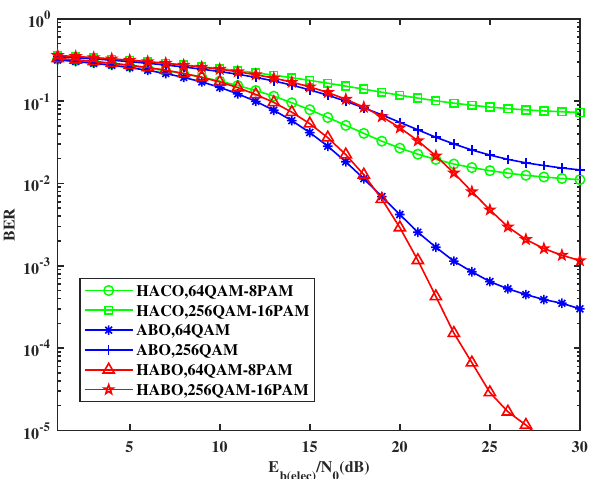
Figure 5. BER of HACO-OFDM, ABO-OFDM, and HABO-OFDM versus E b ( elec ) / N 0 when the clipping ratio is set to 9